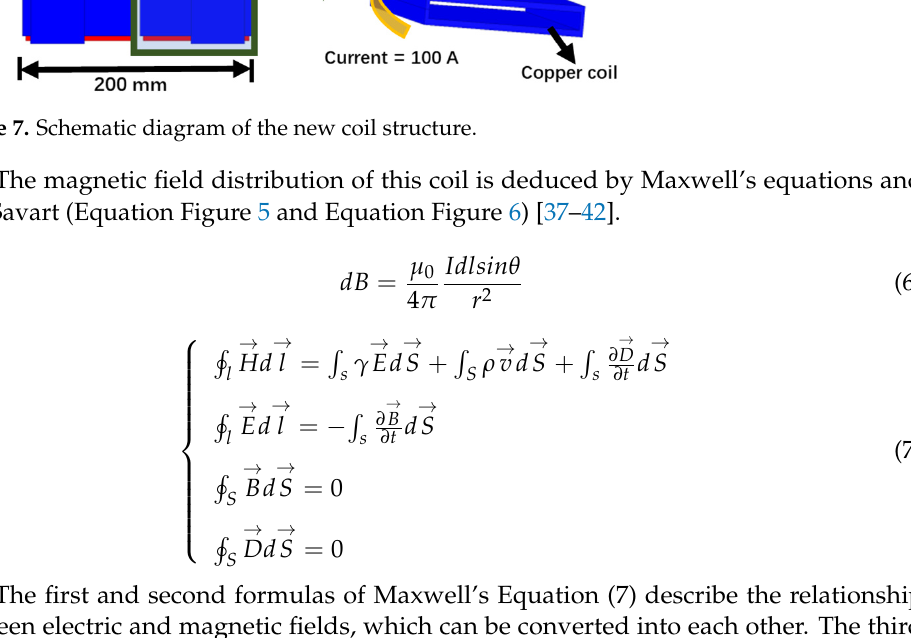
Figure 6. Magnetic field distribution of cross coupling coils.